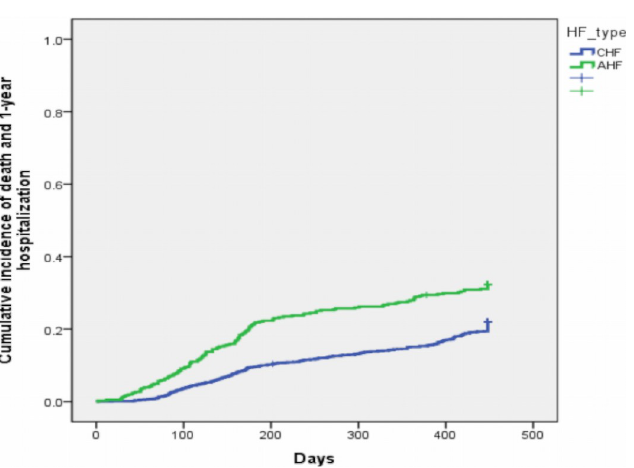
Fig 2. Cumulative incidence plots of death and heart failure (HF) hospitalization in acute heart failure and chronic heart failure patients.